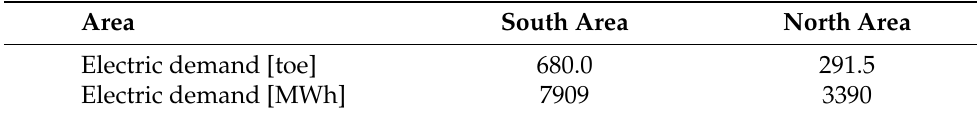
Table 7. Energy demand by area (average of the years 2015 and